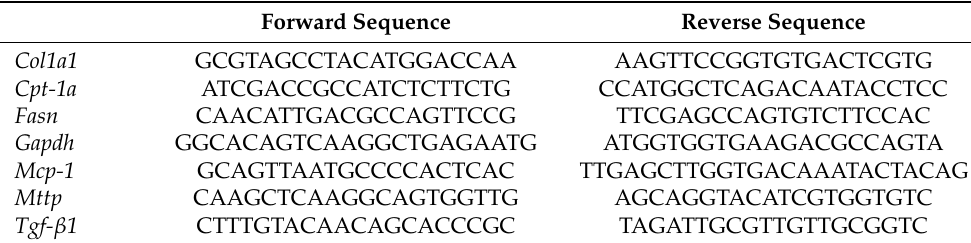
Table 5. Primer sets for real-time PCR